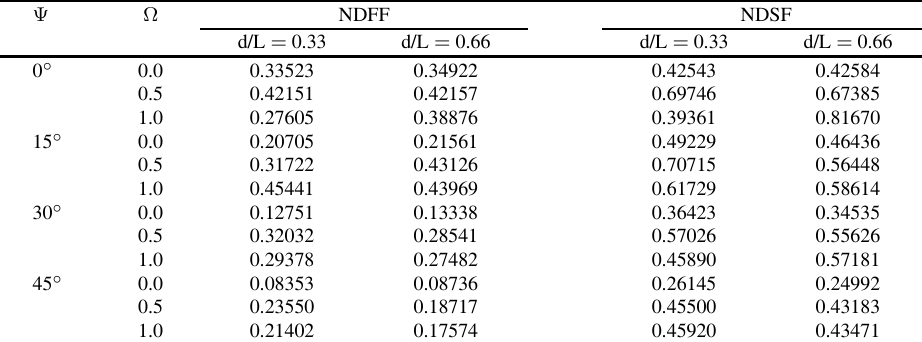
Table 7 NDFF and NDSF of symmetric eight layered [0 ◦ /90 ◦ /0 ◦ /90 ◦ /90 ◦ /0 ◦ / 90 ◦ /0 ◦ ] graphite-epoxy cross-ply